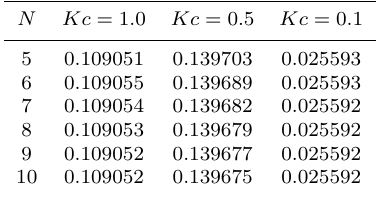
Table 1. Values of | R | with truncation number N at d